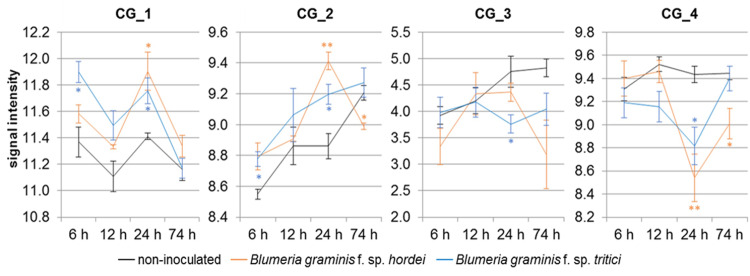
Relative expression of the four Candidate Genes (CG) in powdery mildew attacked epidermis cells.The quantile-normalized signal intensities represent the relative expression of each CG based on Microarray data [68] for non-inoculated, Blumeria graminis f. sp. hordei (isolate CH4.8) or Blumeria graminis f. sp. tritici (isolate FAL 92315) inoculated epidermal peels of the resistant barley cultivar Vada for the indicated time points post-inoculation. The data embody arithmetic means (n = 3) plus standard error of the mean. * p-value < 0.05; ** p-value < 0.01.